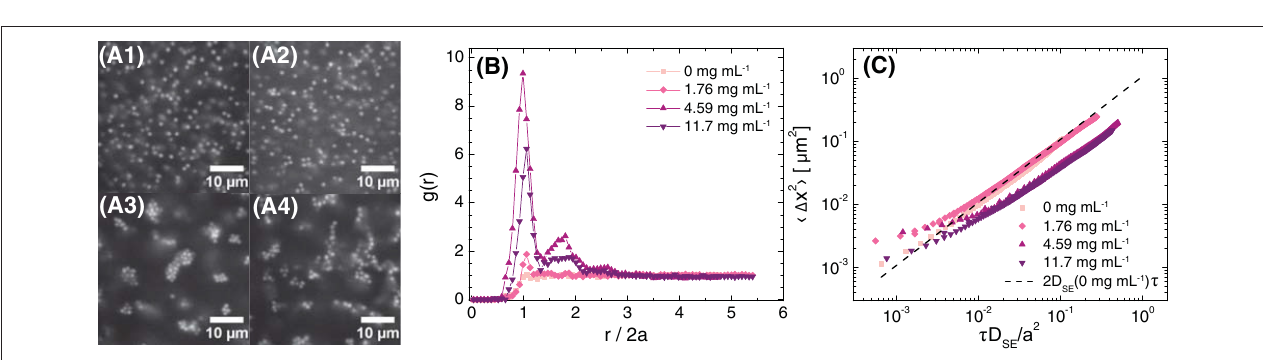
FIGURE 4 | (A) Confocal micrographs at z = 30 µ m, (B) radial distribution function as a function of normalized distance from the particle center, and (C) 1-dimensional mean-squared displacement as a function of delay time for φ = 0.30 suspensions in 80 (w/w)% glycerol in water and various concentrations of NaCl. The concentrations of NaCl are (A1) 0 mM, (A2) 20.1 mM, (A3) 29.4 mM, and (A4) 50.0 mM. The dashed line in (C) is the MSD calculated for Stokes-Einstein diffusion in 80 (w/w)% glycerol in water with 20 mM NaCl.